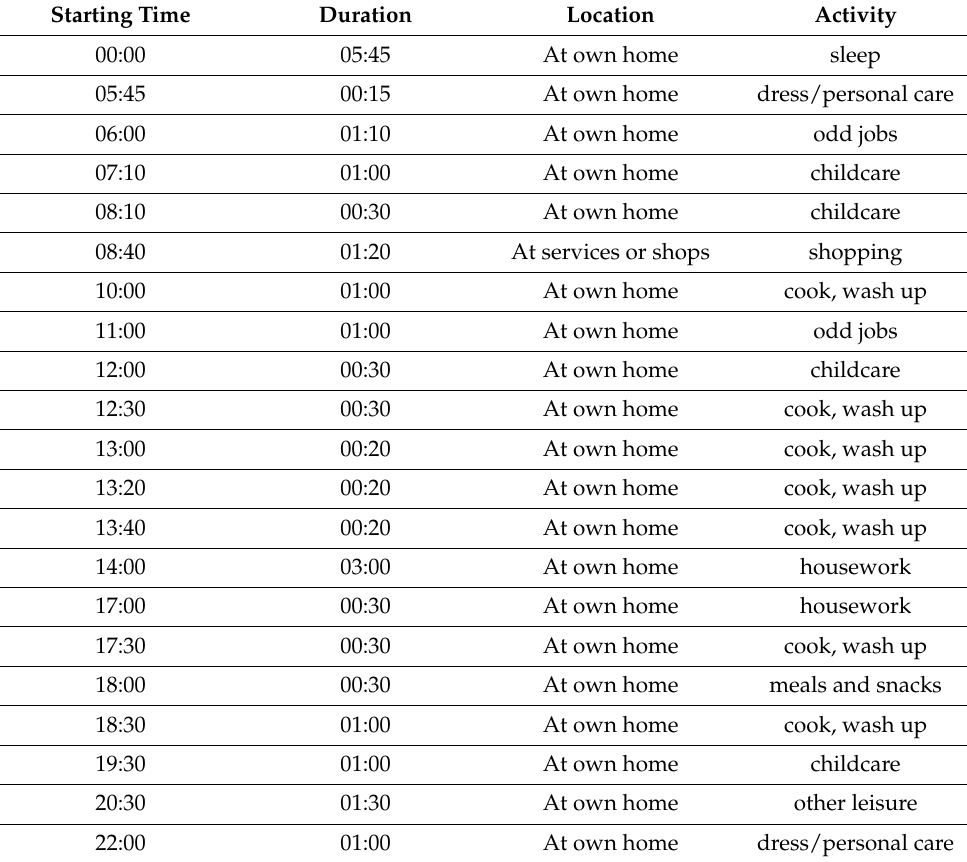
Table A1. Example of time-use survey (TUS) data for one woman of a single day during May in Germany. A TUS is comparable to diaries that characterize how people spend their time. Data are published anonymized, but contain personal information such as age and gender. The activities build harmonized groups to allow easier comparison. The total dataset for Germany consists of 105,000